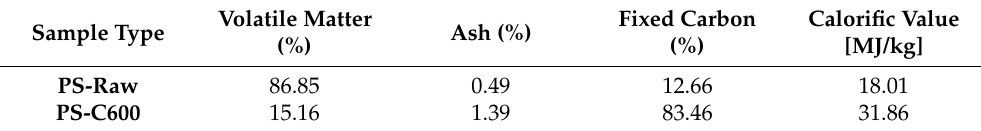
Table 2. Proximate analysis for biomasses and biochar on a dry basis.